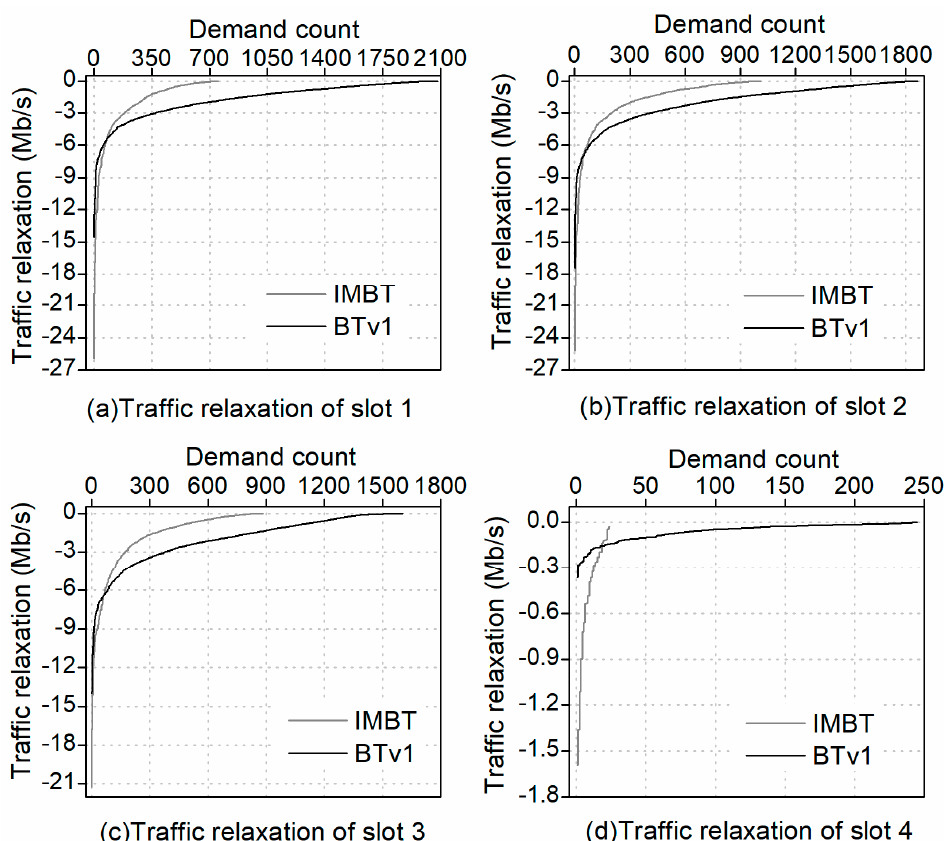
Figure 10. ( a ), ( b ), ( c ), ( d ) is the traffic relaxation in slot 1,slot 2,slot 3 and slot 4 of IMBT and BTv1 of Germany50 under the size of BT group is 300